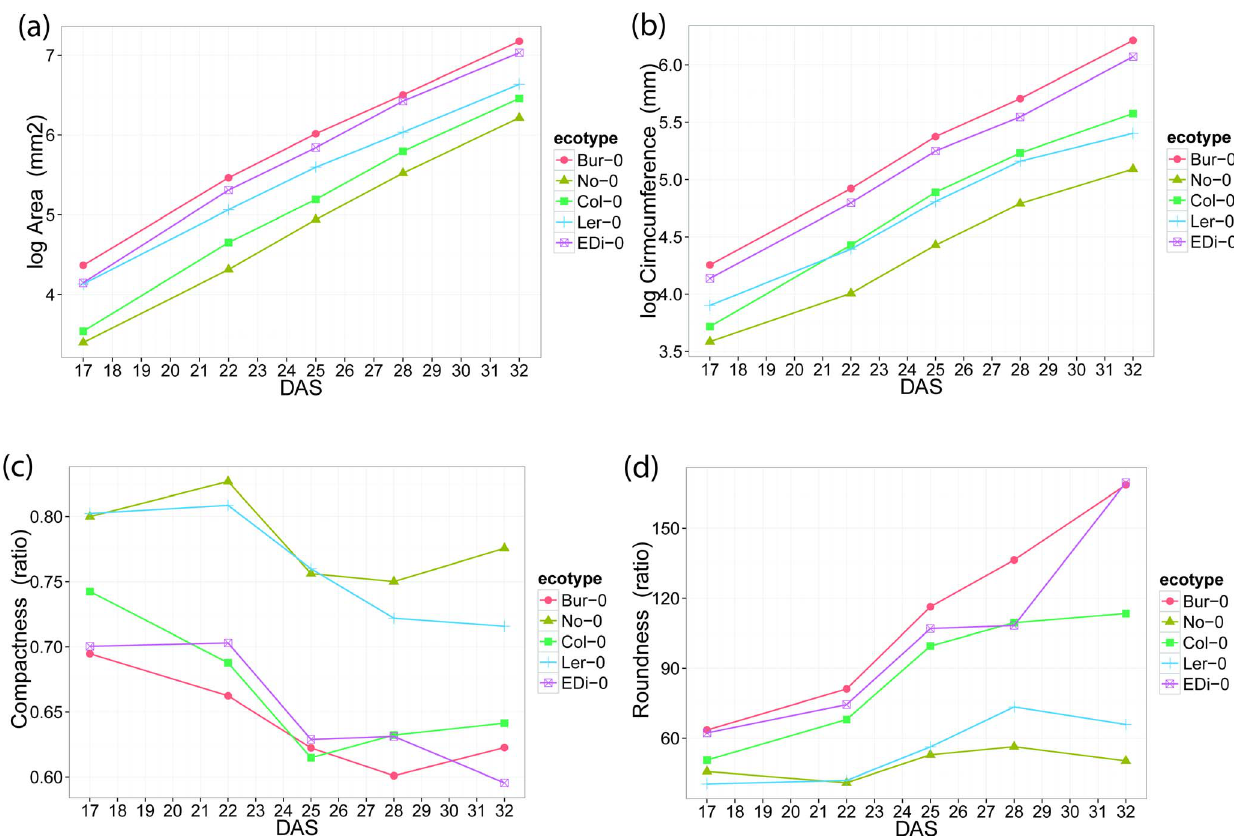
Figure 3. Time course for selected genotypes from statistical model for (A) log e Area (B) log e Circumference (C) Compactness and (D) Roundness.